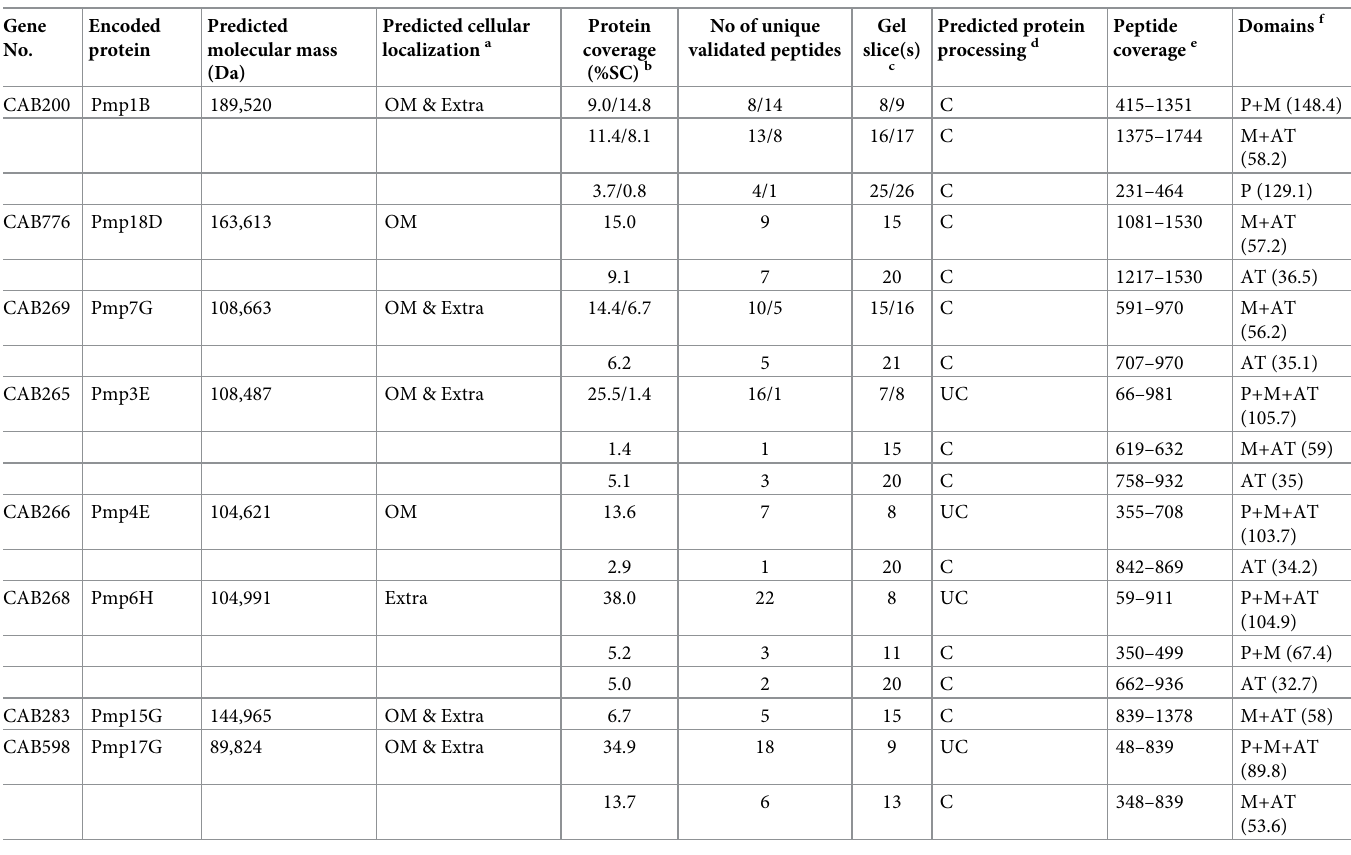
Table 2. C . abortus S26/3 COMC proteins with evidence of cleavage. Gene